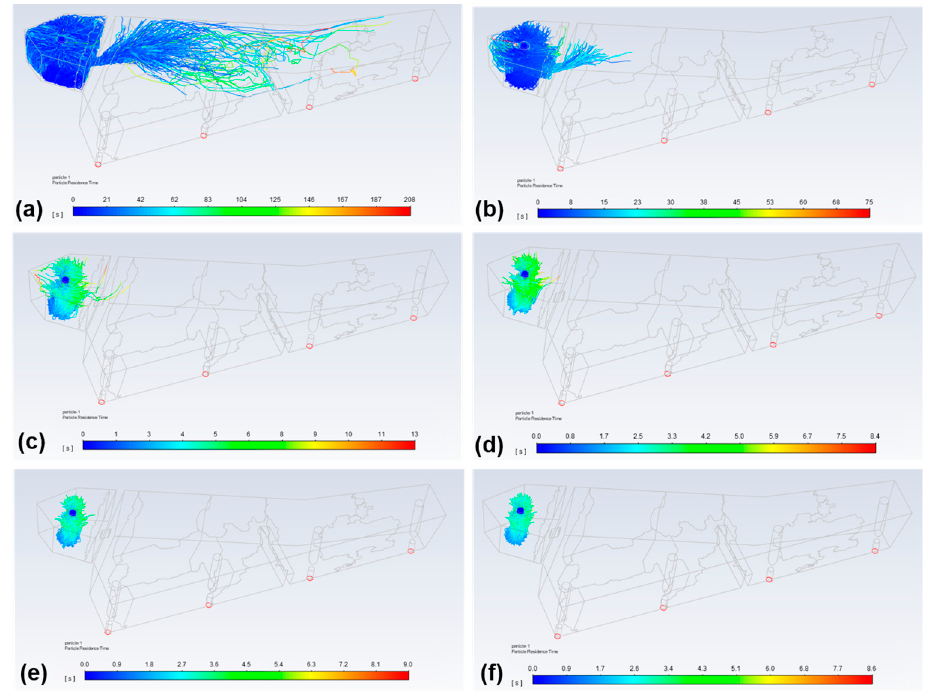
Figure 10. Motion trace and residence time of bubbles at different sizes: ( a ) 0.134, ( b ) 0.402, ( c ) 0.670, ( d ) 0.938, ( e ) 1.206, and ( f ) 1.474 mm.